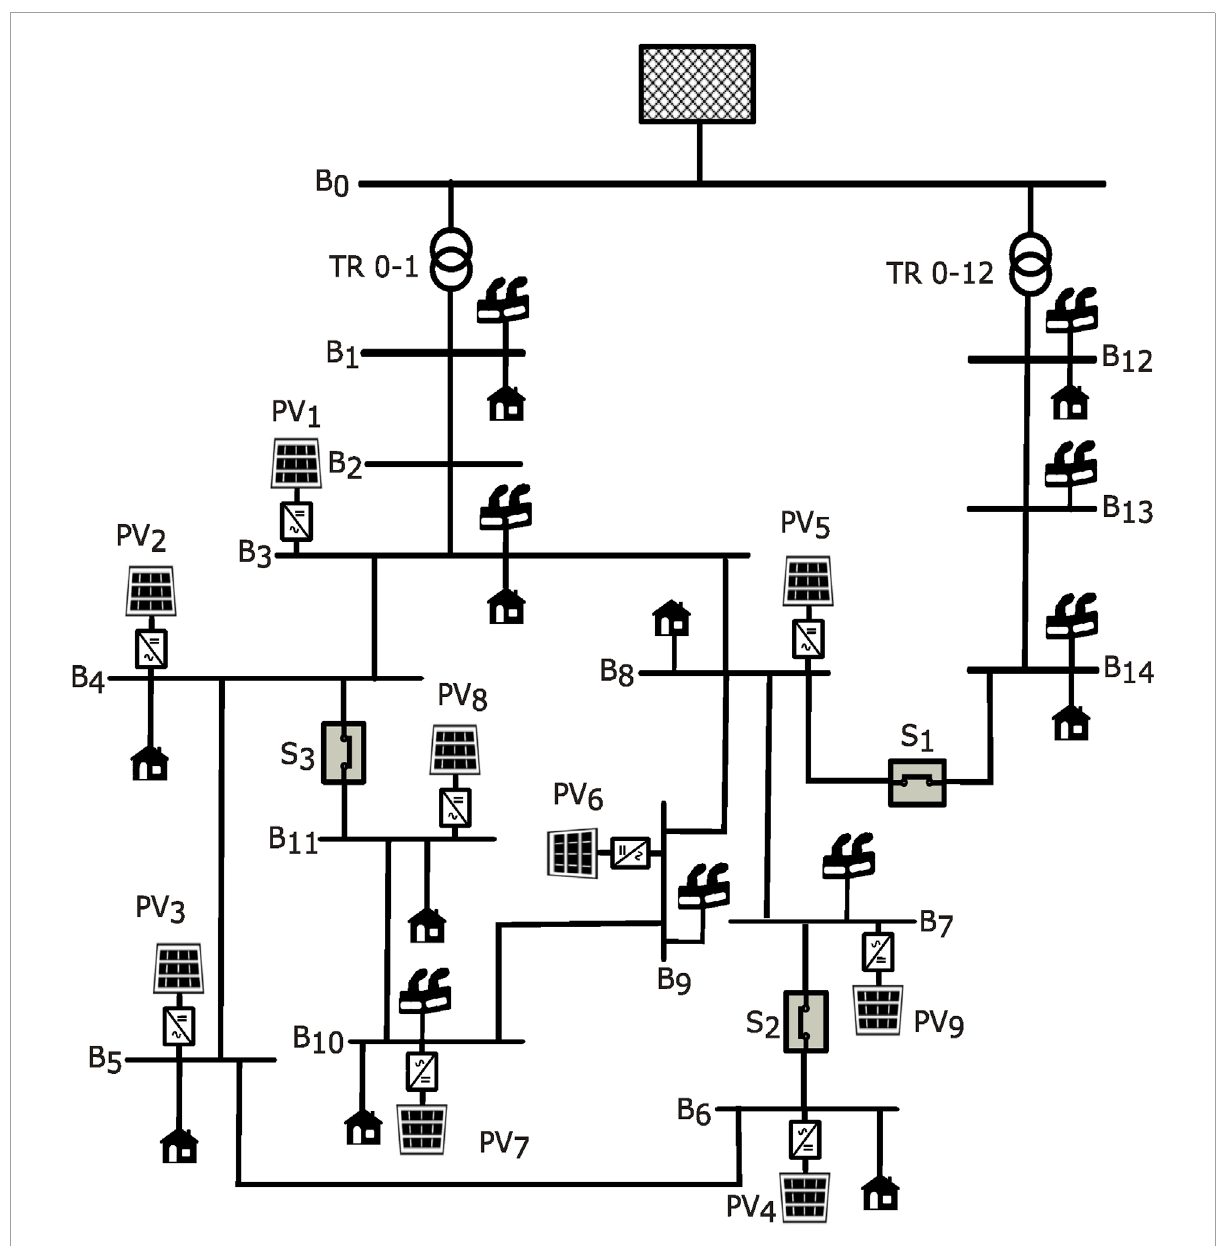
FIGURE 5 Layout of CIGRE network with loads and DERs (Barsali et al., 2014).